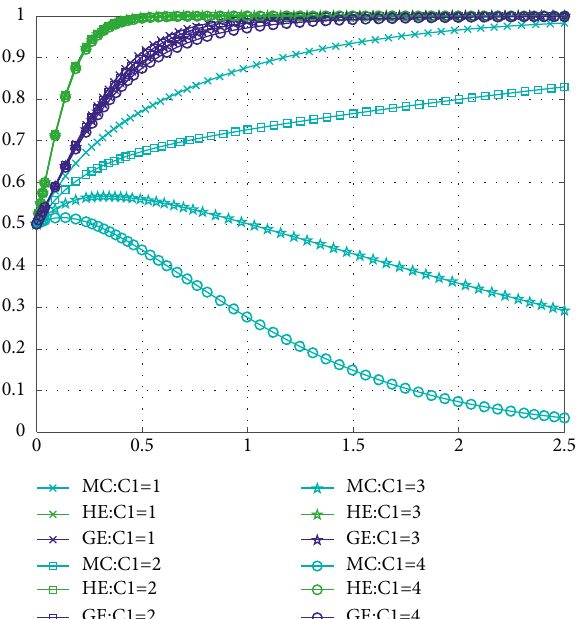
Figure 3: The evolutionary result of the change in incentive regulation cost C